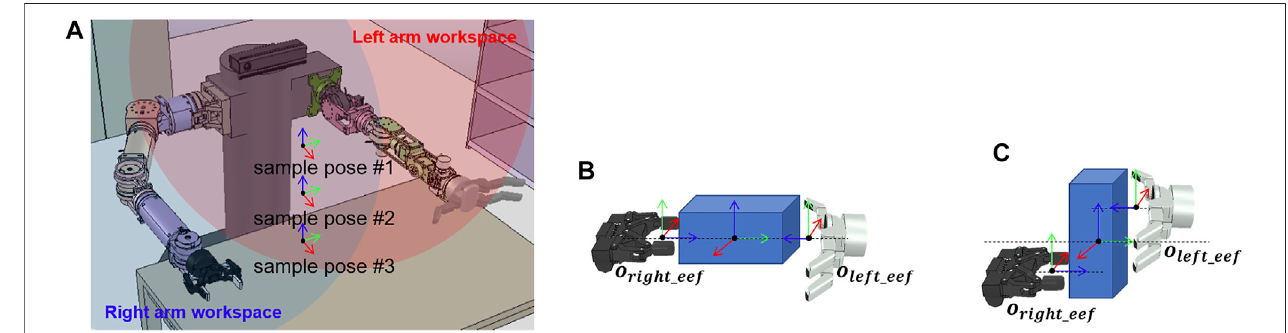
FIGURE7| Sampleposesoftheobjectandtherobotend-effector, whichareusedtocalculatethehandovermotion. (A) Sampleposesoftheobjectlocatedinthe dual-arm workspace. (B) Sample pose of the left and right end-effectors when the object is lying down. (C) Sample pose of the left and right end-effectors when the object is standing.